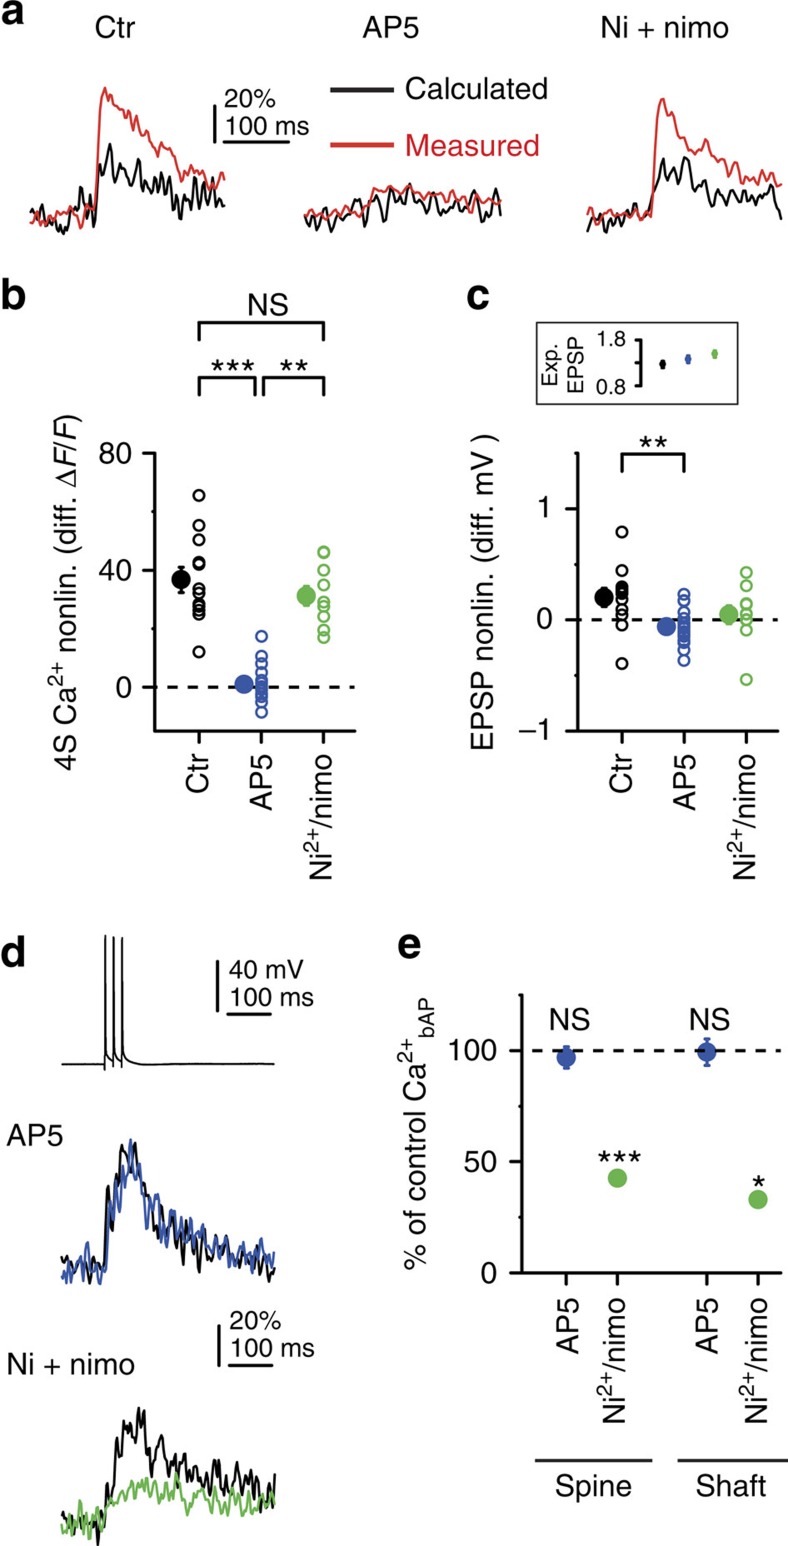
Cooperative spine Ca2+ signalling at distal dendritic locations is mediated by NMDARs.(a) Calculated and measured spine Ca2+ signals from representative experiments using the 4S protocol (averaged data from all four spines shown in each case) at distal segments of oblique and basal dendrites under control conditions (left), in the presence of AP5 (100 μM, middle) or in the presence of Ni2+ (100 μM) and nimodipine (20 μM) (right). (b,c) Summary of cooperative spine Ca2+ nonlinearity (b, multiple comparisons after Kruskal–Wallis test with P<0.001) and somatic EPSP nonlinearity (c, multiple comparisons after Kruskal–Wallis test with P<0.01) measured with the 4S protocol under control conditions (black, n=12 in 12 dendrites, five cells), in the presence of AP5 (blue, n=16 in 10 dendrites, three cells) and in the presence of Ni2+ and nimodipine (green, n=10 in 10 dendrites, four cells). Inset in c shows similar calculated EPSPs under all conditions (Kruskal–Wallis test, P=0.116). (d) bAP-induced responses. Upper, representative somatic voltage trace of three APs evoked at 50 Hz (single recording). Middle, spine Ca2+ signals before (black) and after application of AP5 (blue). Lower, spine Ca2+ signals before (black) and after application of Ni2+ and nimodipine (green). (e) Summary of the effect of AP5 (blue) and VGCC blockers (green) on bAP-evoked spine (AP5: n=35, P=0.461; VGCC blockers: n=24, P<0.001; 3–4 spines per dendrite, Wilcoxon test) and shaft (AP5, n=10 dendrites, P=0.507; VGCC blockers: n=7 dendrites, P<0.05, Wilcoxon test) Ca2+ signals. Filled symbols and error bars represent mean±s.e.m. Ctr, control; diff., difference in; exp., expected; nonlin., nonlinearity; nimo, nimodipine.